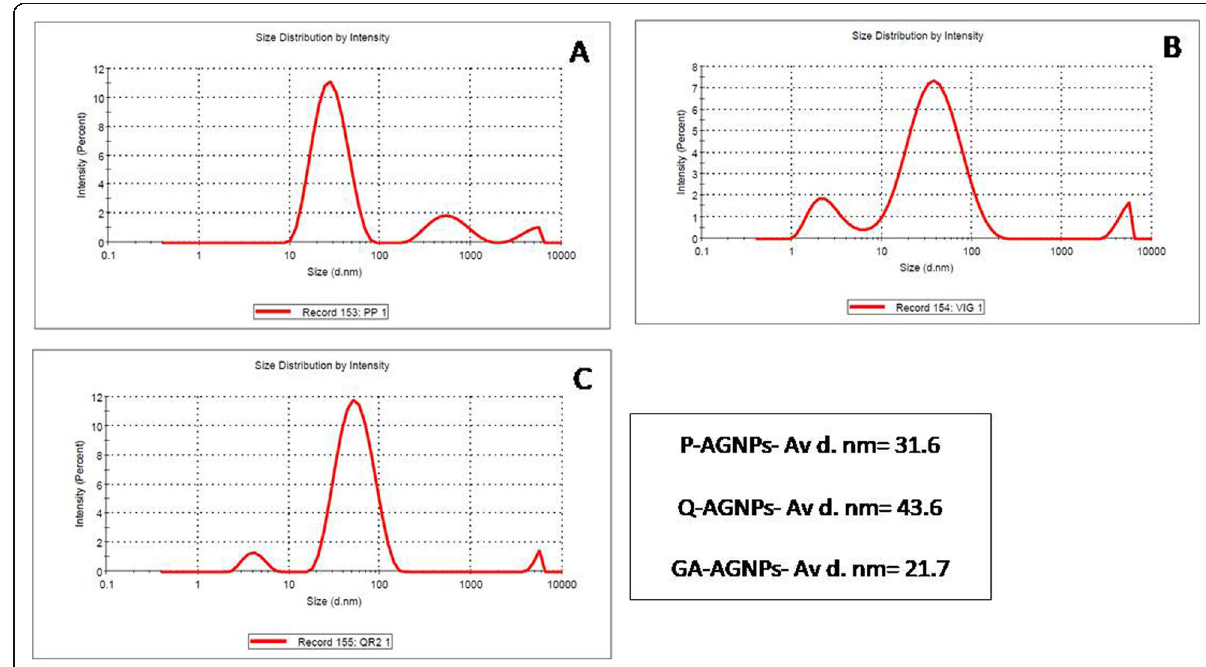
Fig. 6 a – c The average particle size distribution of biosynthesized AgNPs. a P-AgNPs. b Q-AgNPs. c